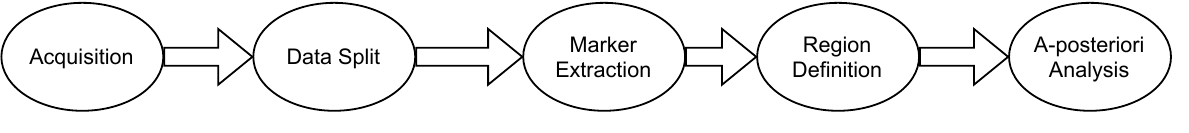
Figure 2. Detection model